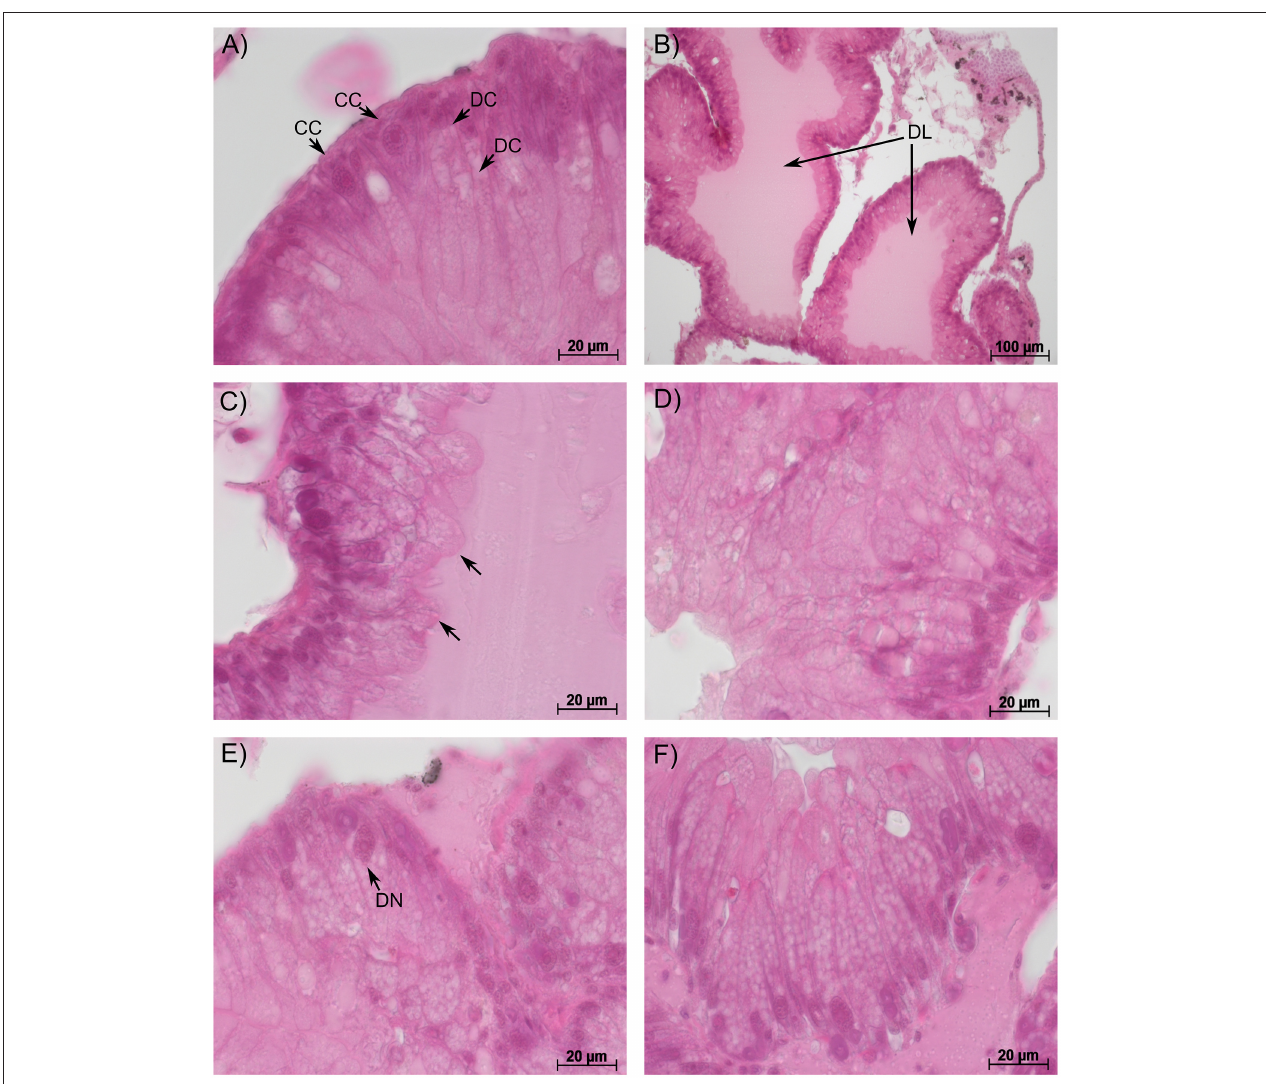
FIGURE 1 | Representative sections of the hepatopancreas in big ramshorn snails. (A) : control snails showed conically shaped crypt cells [CC] with a large nucleus and column-shaped digestive cells [DC] with vacuoles increasing in size from the apex to the base; (B) : snails exposed to 100 mg/L guanylurea showed a dilated lumen [DL] of the tubules; (C) : in snails exposed to 10 mg/L metformin, the apex of the digestive cells was irregularly shaped and protruded into the lumen [arrow]; Snails exposed to 100 mg/L guanylurea displayed (D) irregularly shaped digestive cells with an affected cell compartmentation, (E) deformation of crypt cell nuclei [DN] and (F) a severe vacuolisation of the hypertrophic crypt cells. In this exposure group almost all crypt cells were hypertrophic and increased in number. All sections were stained with